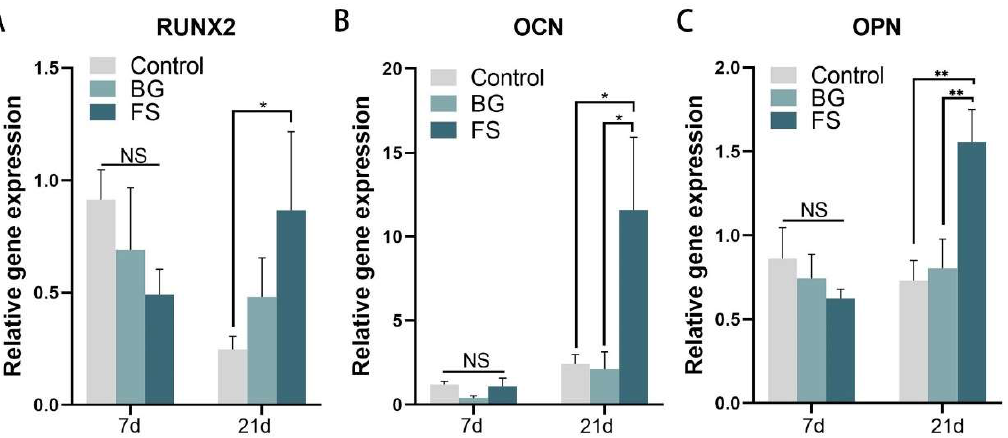
Figure 9. The relative expression of RUNX2 ( A ), OCN ( B ), and OPN ( C ) in the glass slide control, BG and FS group (NS, p > 0.05, * p < 0.05, ** p <